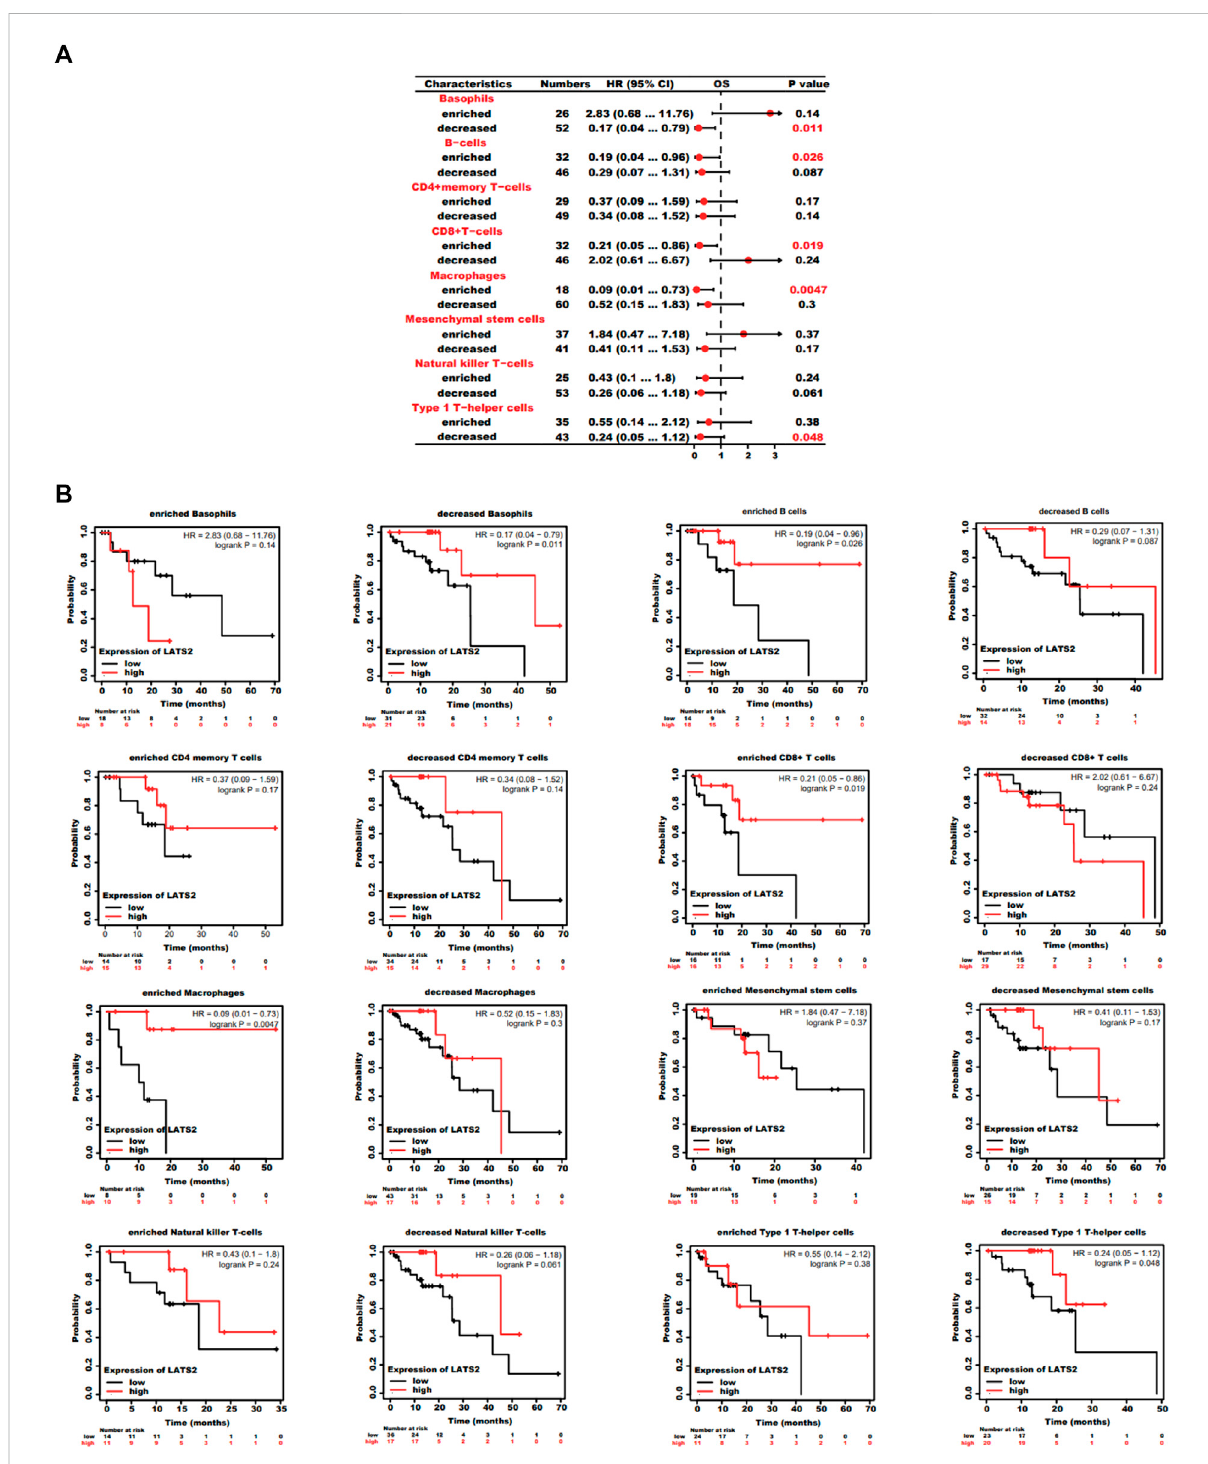
FIGURE 7 (A) Forest plot shows the prognostic value of LATS2 expression according to different immune cell subgroups in ESCC patients. (B) Kaplan – Meier plot was used to estimate the correlation between LATS2 expression and OS in different immune cell subgroups of ESCC